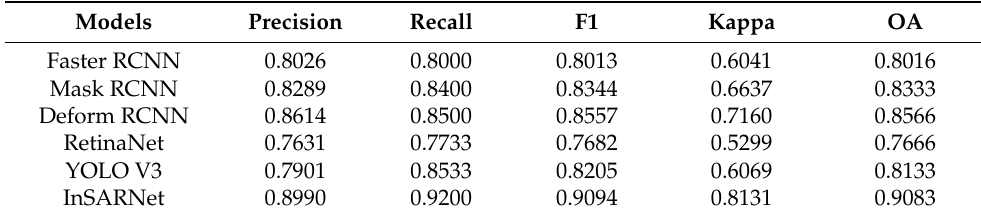
Table 9. Comparison of the accuracies of the different detection models in test area B.